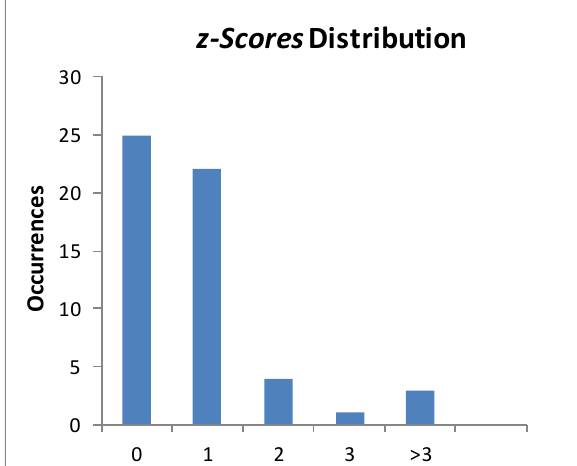
Figure 9. Distribution of all z-scores (by position analysis and by ‘sestet’ analysis) obtained by all the participants.